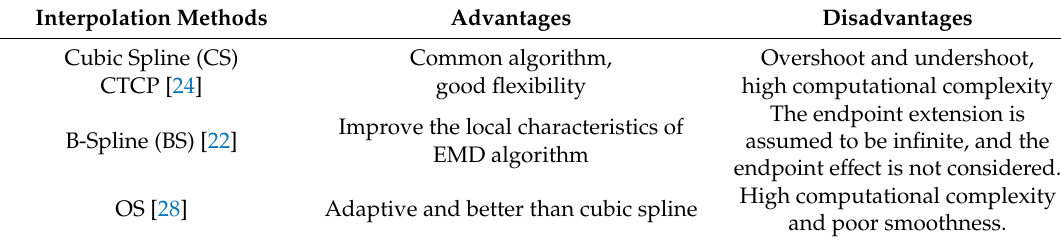
Table 1. Common interpolation methods and their advantages and